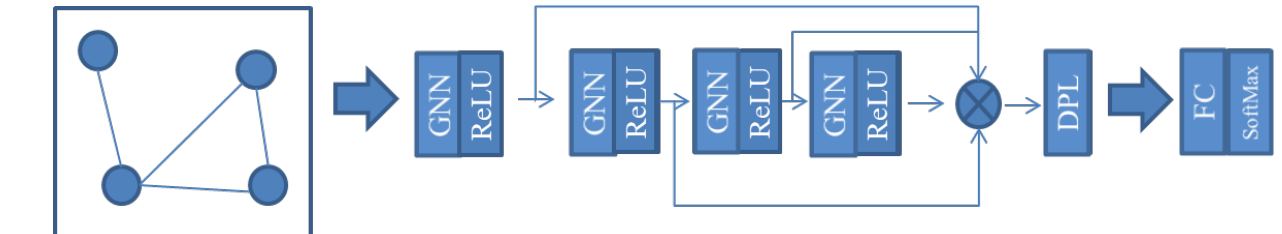
Figure 4. The illustration of the proposed distribution preserving graph representation learning (DPG).